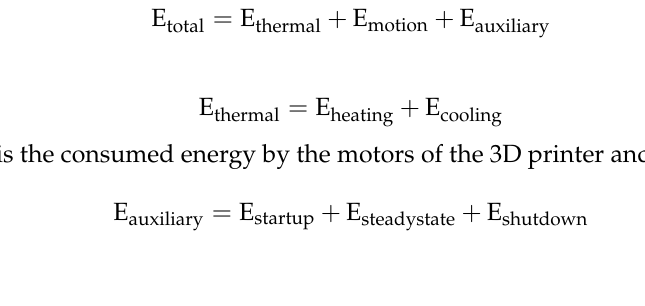
Figure 3. Graphic representation of the 3D printing process, defining the 3D printing parameters studied in this work. On the right side of the figure, the 3D printing parameter values and the geometry of the compression test sample fabricated following the ASTM D695 standard are presented.